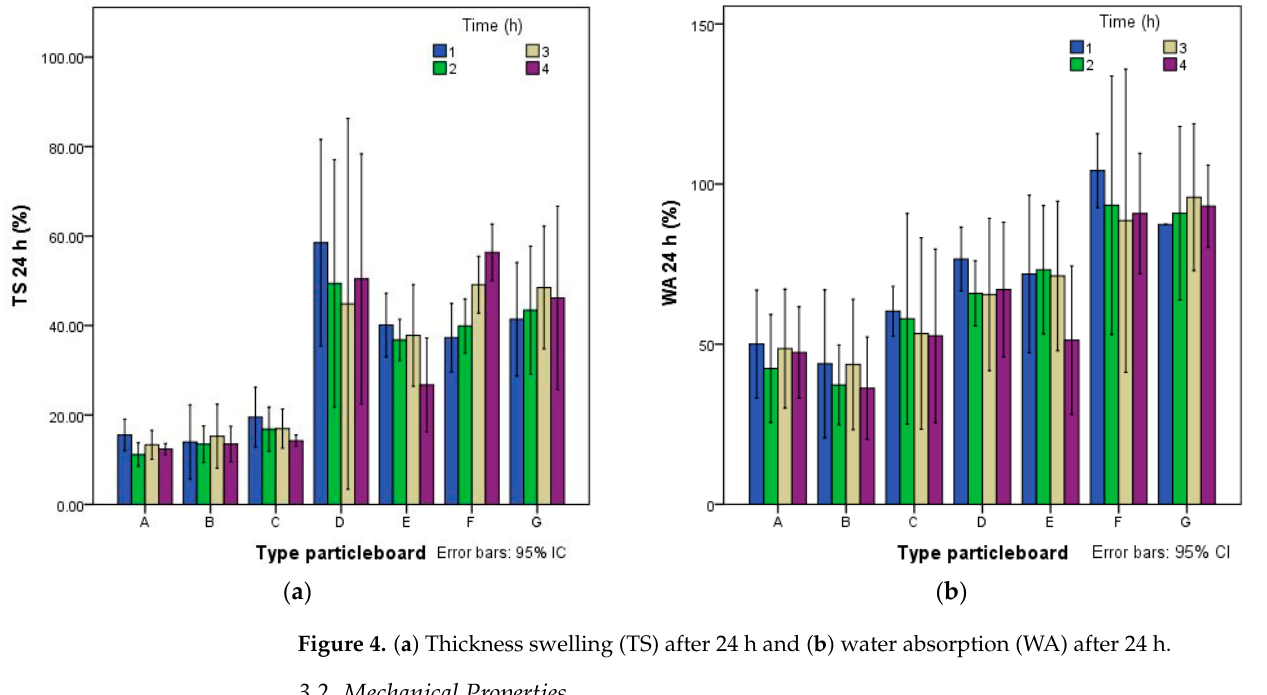
Figure 4. ( a ) Thickness swelling (TS) after 24 h and ( b ) water absorption (WA) after 24 h.